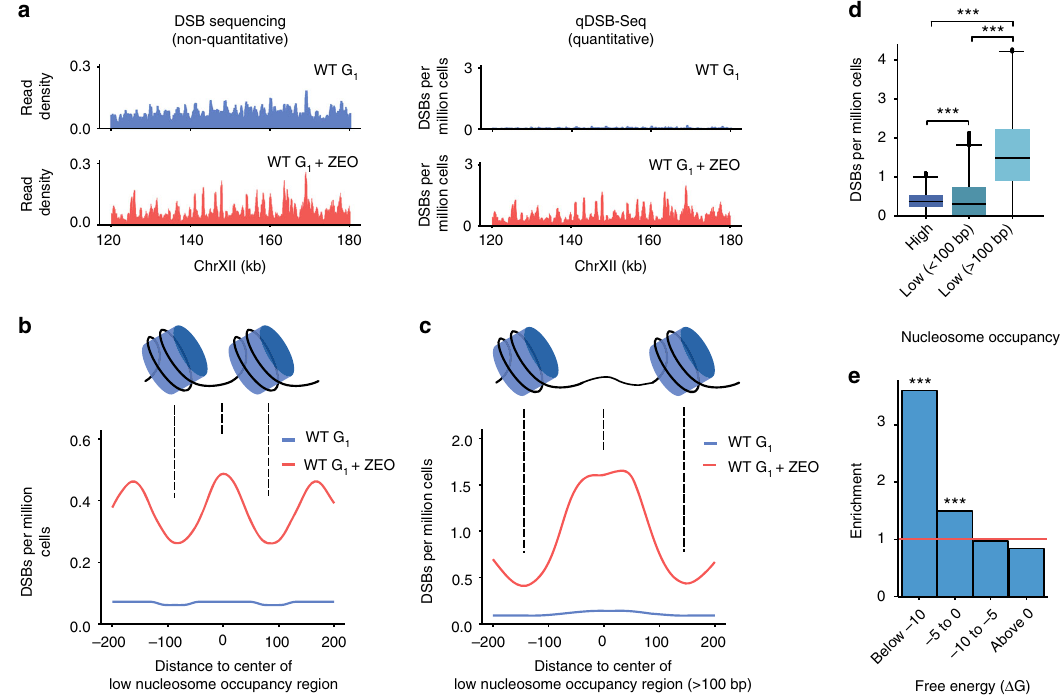
Fig. 3 Quanti fi cation of Zeocin-induced DSBs. a Results of regular DSB sequencing (left, i-BLESS) and quantitative DSB sequencing (right, qDSB-Seq) in a representative fragment of chromosome XII for untreated and Zeocin-treated (ZEO) wild-type (WT) G 1 -phase cells. For DSB sequencing, read density was normalized to the total number of reads in the sample and thus results do not allow for quantitative comparison between DSBs present in ZEO and G 1 samples. For qDSB-Seq, results are quantitative and DSB density within 500 bp sliding window with 50 bp step is shown. b , c Density of Zeocin-induced DSBs in ( b ) all and ( c ) ≥ 100 bp low nucleosome occupancy regions. Nucleosome locations from Lee et al. 21 were used; DSB densities, expressed as DSBs per million cells, were calculated in a 50 bp sliding window with a 5 bp step. d Comparison of DSB densities in high nucleosome occupancy regions (High) and low nucleosome occupancy regions (Low). Median (center line), fi rst, and third quartiles (box limits), and 1.5 times the interquartile range